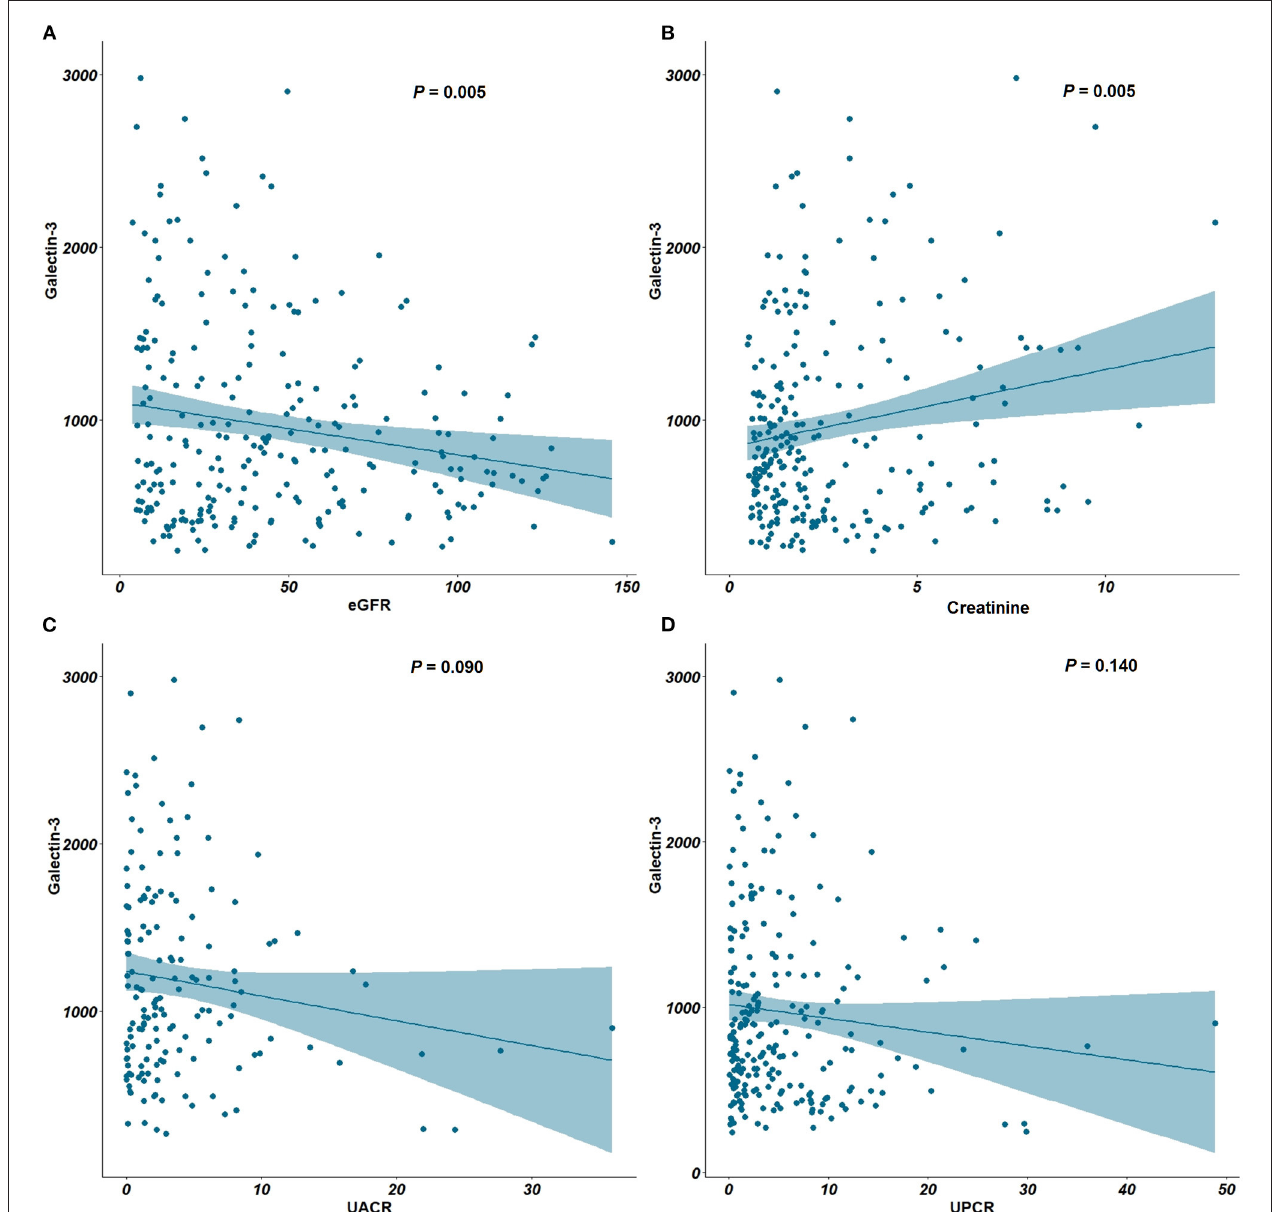
FIGURE 1 | Correlation between plasma Gal-3, eGFR, creatinine, UACR and UPCR. (A) Correlation plots between Gal-3 and eGFR. (B) Correlation plots between Gal-3 and creatinine. (C) Correlation plots between Gal-3 and UACR. (D) Correlation plots between Gal-3 and UPCR. Gal-3, Galectin-3; eGFR, estimated glomerular filtration rate; UACR, urine albumin-creatinine ratio; UPCR, urine protein-creatinine ratio.